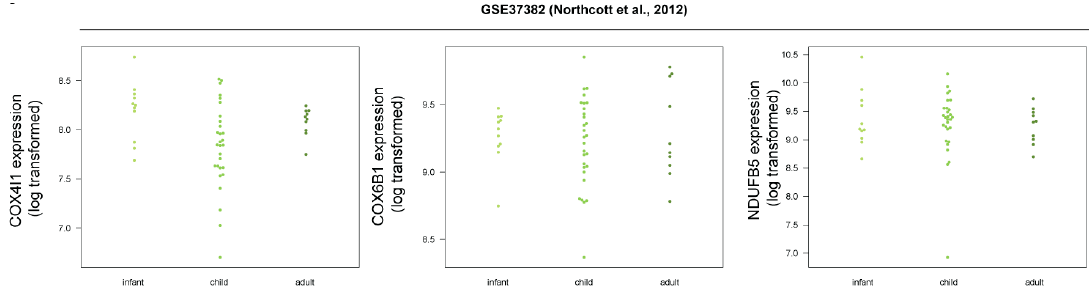
Figure 7. Mitochondrial respiratory chain genes do not show different gene expression patterns in human SHH-MB depending on patient age group. Expression data derived from microarray analysis were downloaded from GEO and processed as in Figure 2.